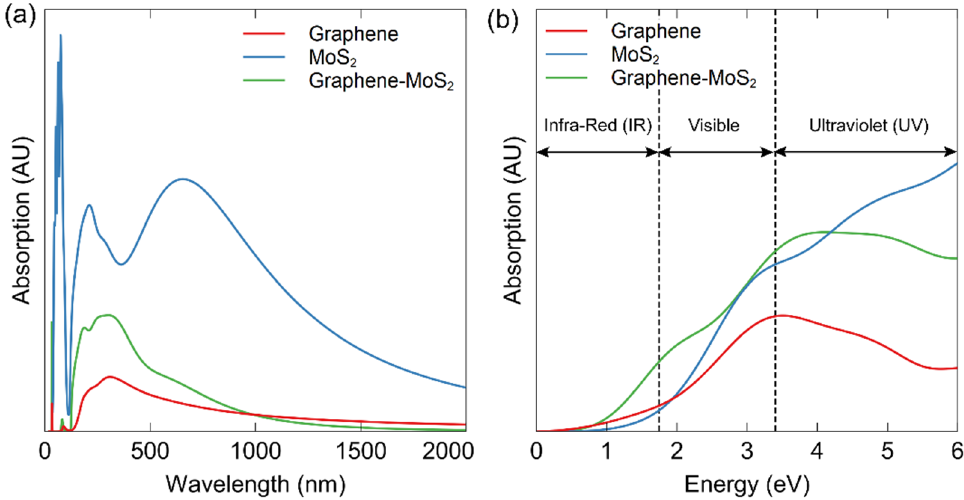
Figure 5. Theoretical absorption spectrum of graphene, MoS 2 , and graphene-MoS 2 as a function of ( a ) wavelength and ( b ) energy.